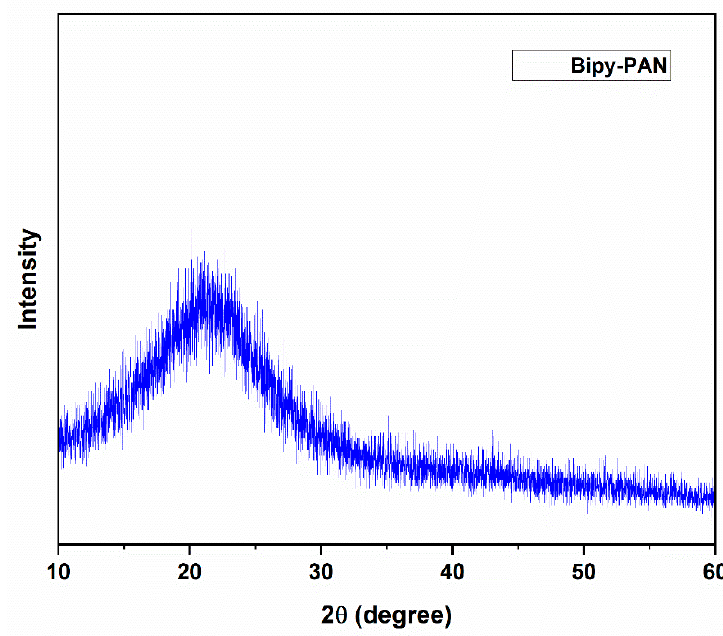
Figure 3. XRD pattern of Bipy-PAN.